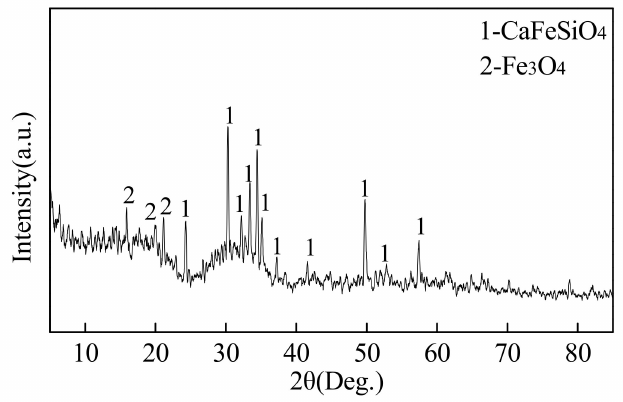
Figure 4. XRD pattern of dephosphorization slag in Heat 1.